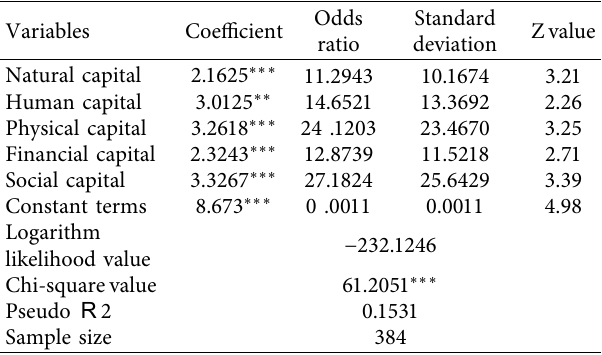
Table 3: The regression results of the sustainable livelihood capital of the family to the scale of